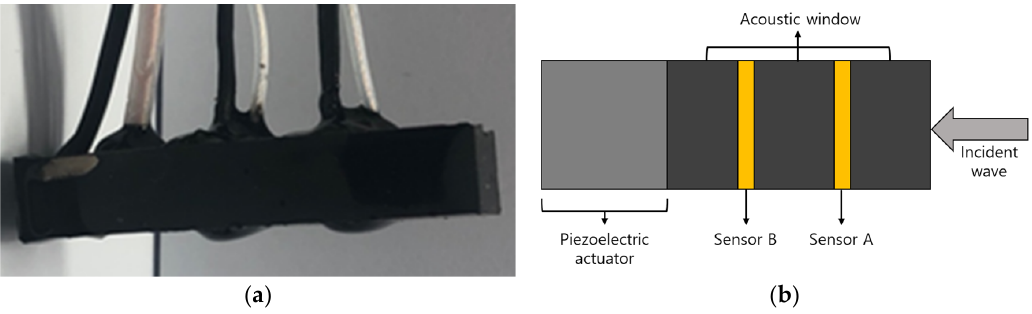
Figure 1. Smart skin acoustic absorber system: ( a ) the fabricated sensor and ( b ) the concept of the sensor.